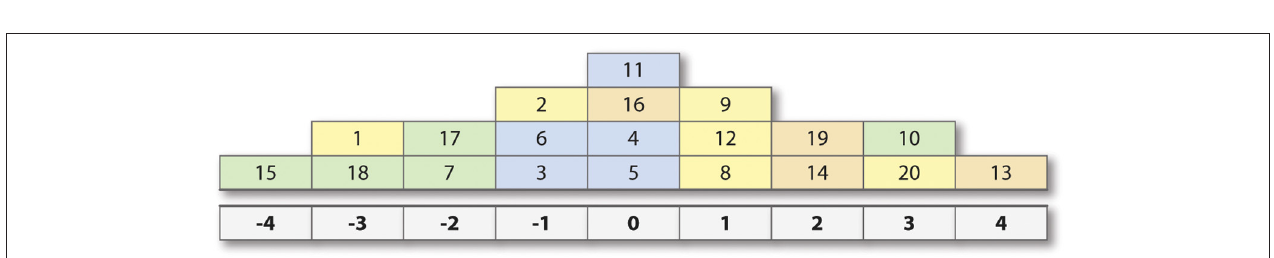
FIGURE 4 | Ideal sort for factor 2. Factor name was chosen based on statements 15 and 5. Color coding is based on the four pillars of sustainability (green = biological sustainability, blue = economic sustainability, Red = social sustainability, and yellow = institutional sustainability).